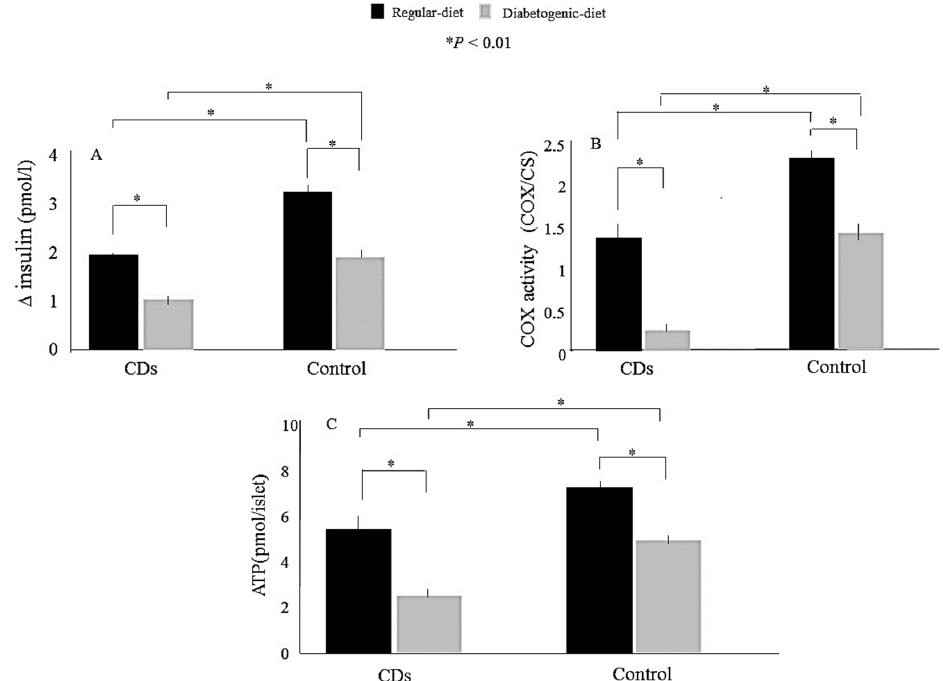
Figure 9. ( A ) Glucose-stimulated insulin secretion (GSIS), ( B ) cytochrome c oxidase (COX) activity, and ATP content ( C ) in islets isolated from Cohen diabetic sensitive (CDs) rats or control rats fed either a regular diet (black bars) or a diabetogenic diet (gray bars). ( A ) GSIS measured at 1.7 (baseline) and 16.7 mmol/L (stimulatory) glucose concentrations. ( B ) COX activity normalized to citrate synthase (CS) activity (COX/CS). ( C ) ATP content (pmol/islet) determined by luciferin luciferase. Data are means ± SE for at least three separate experiments. * p < 0.01. Figure is used and modified from [45] with permission from the publisher.